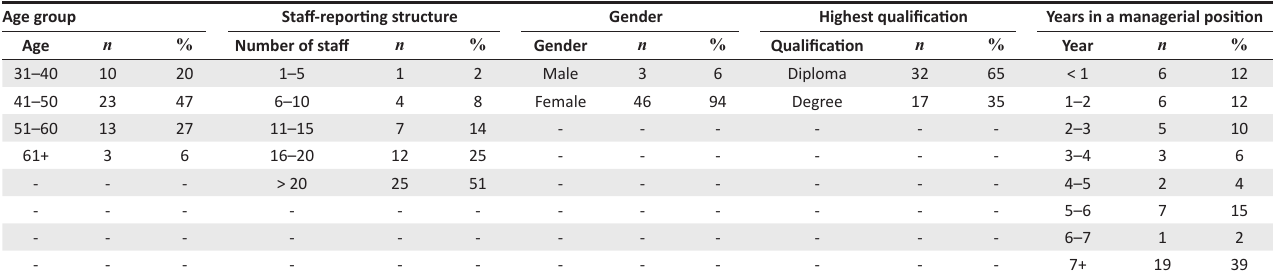
TABLE 2: Aspects investigated as an influence on nurse leaders’ motivation. Age